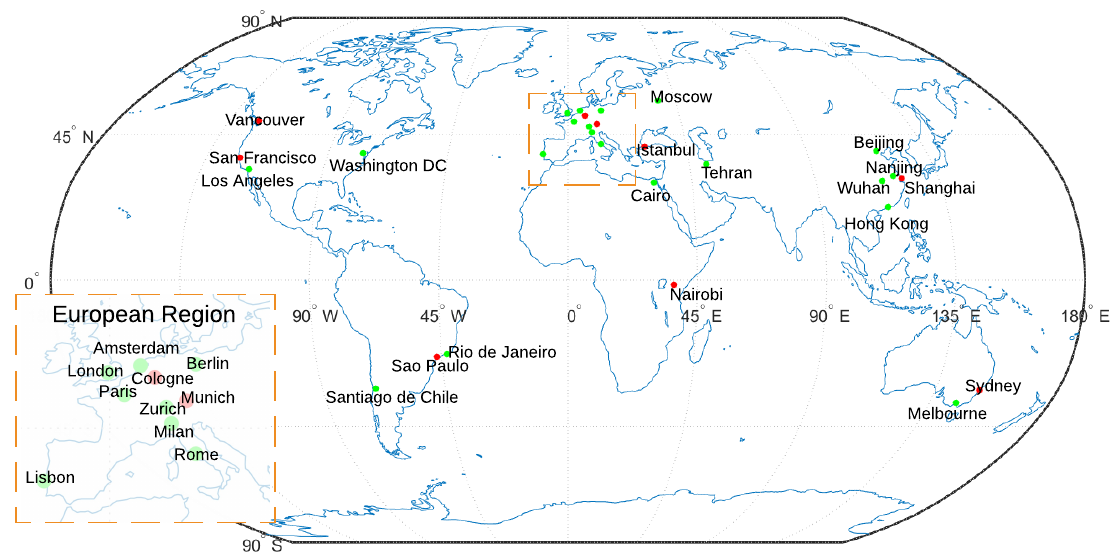
Figure 2. World-wide distribution of selected 29 cities of interest. Red: cities for testing. Green: cities for